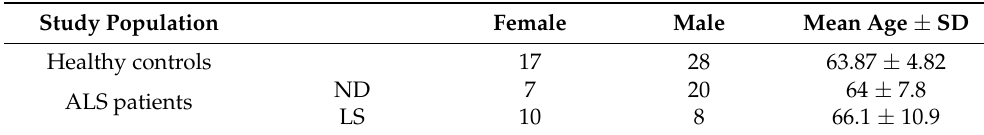
Table 1. Demographic data of investigated groups.